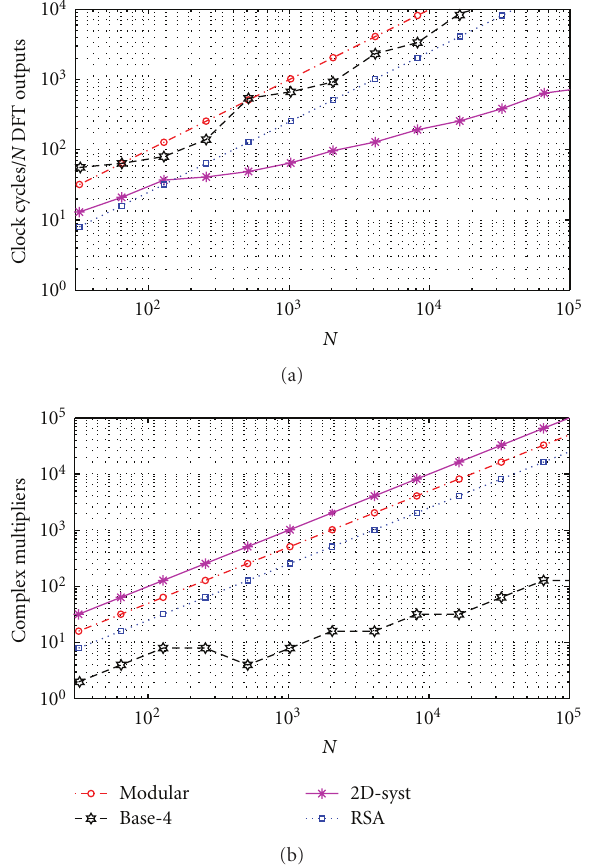
Figure 5: (a) Throughput of RSA, Modular, 2D Systolic, and base-4 based DFT implementations. (b) Complex multiplier requirements of RSA, Modular, 2D Systolic, and base-4-based DFT implementa- tions.